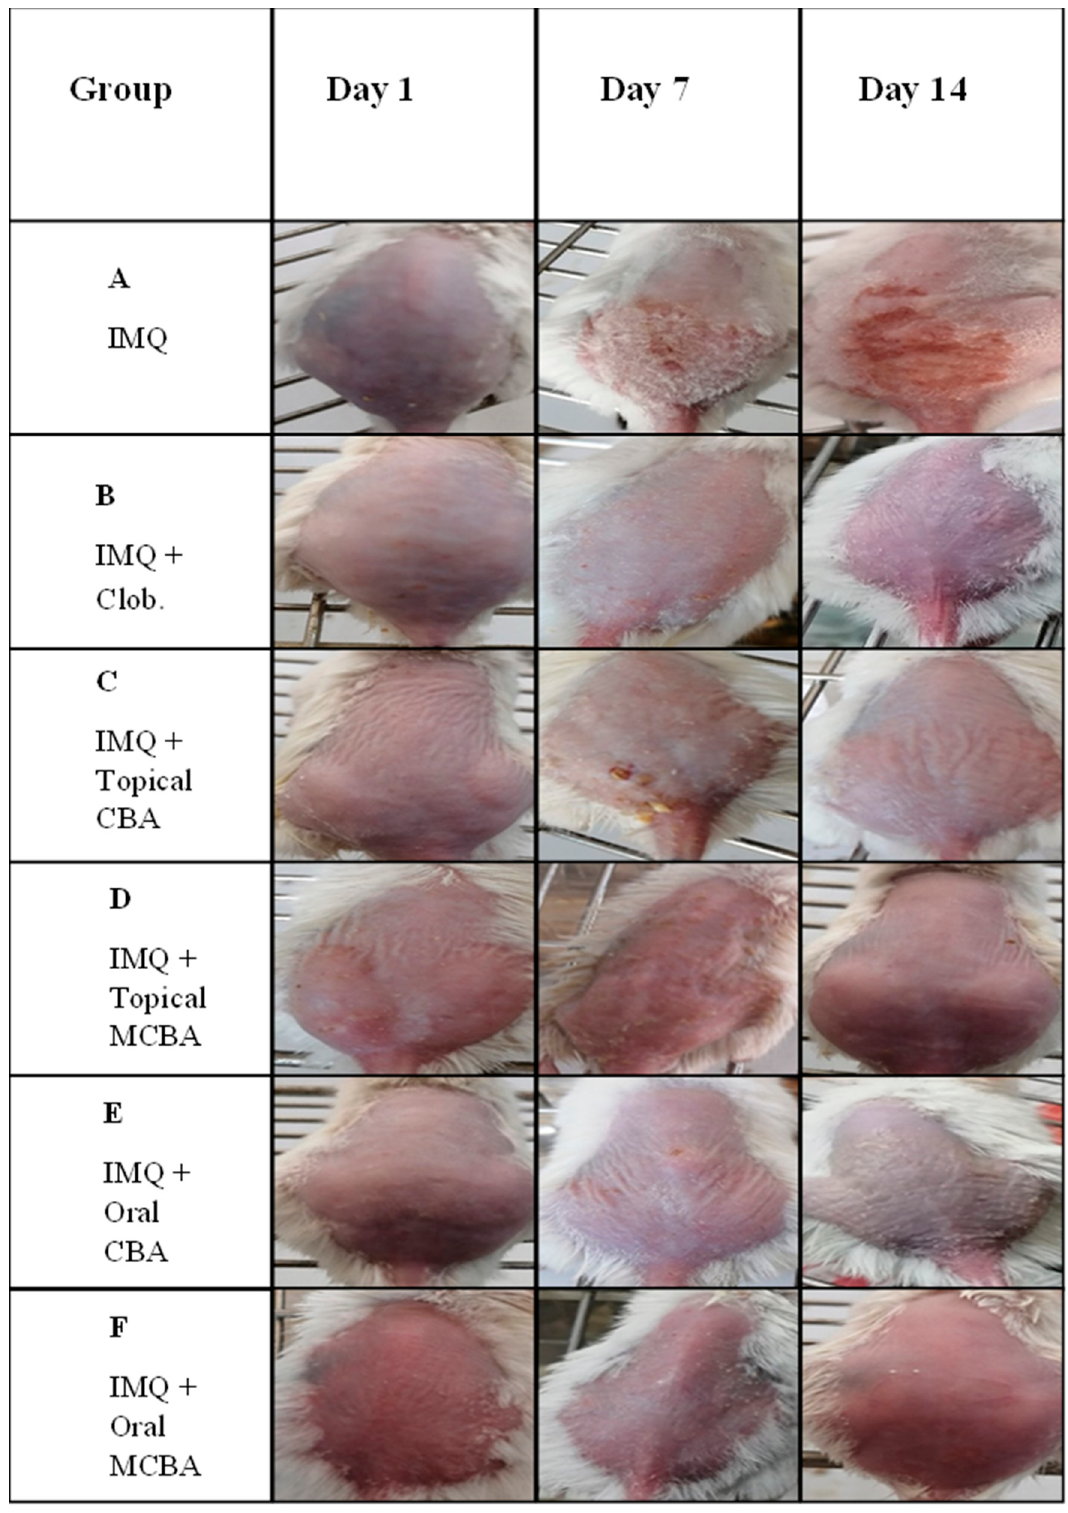
Figure 1. Representative gross skin features in mice of different groups on days 1, 7, and 14. ( A ) IMQ-treated mice. ( B ) Clobetasol propionate (Clob)-treated mice. ( C ) Topical CBA-treated mice. ( D ) Topical MCBA-treated mice. ( E ) Oral CBA-treated mice. ( F ) Oral MCBA-treated mice.